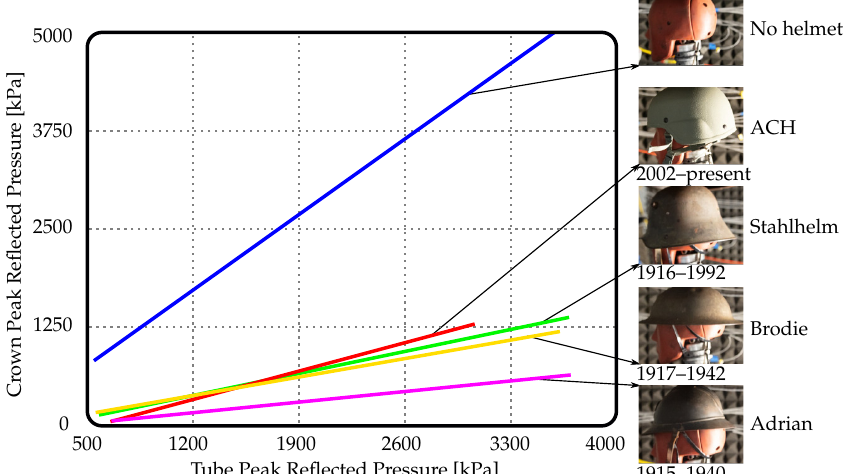
Figure 1. Experimental results (the linear regression fit for each helmet type) from a study by Op’t Eynde et al. (2020)